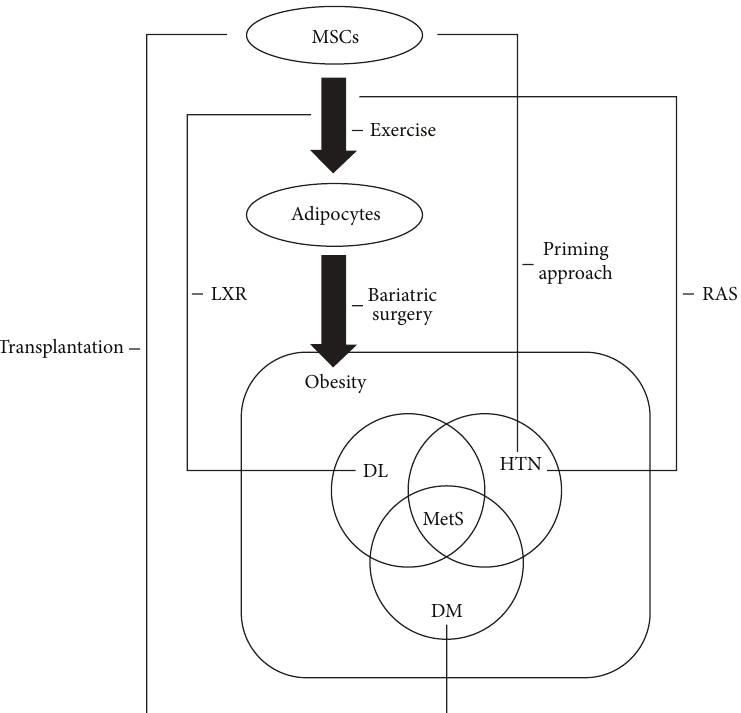
Figure 2: Schema of the clinical impact of MSC adipogenesis on metabolic syndrome. Pathophysiology of metabolic syndrome is quite complex and the precise mechanisms linking each condition remain unclear. Among the potential clinical applications of MSCs, studies assessing MSCs as a source of transplantation material in the treatment of diabetes have shown encouraging results. MSC-based therapeutic options for diabetes could be used in the clinical setting in the future. Although further studies are needed to elucidate the roles of MSCs and MSC adipogenesis in metabolic syndrome, MSC therapy is expected to become a new level of therapeutic option for this syndrome. DL, dyslipidemia; DM, diabetes mellitus; HTN, hypertension; LXRs, liver X receptors; MetS, metabolic syndrome; MSCs, mesenchymal stem cells; and RAS, renin-angiotensin